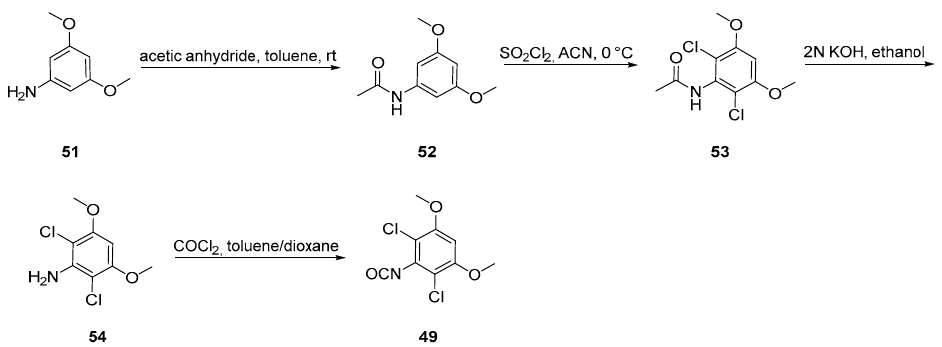
Scheme 7. Preparation of the isocyanate 49 used for the synthesis of